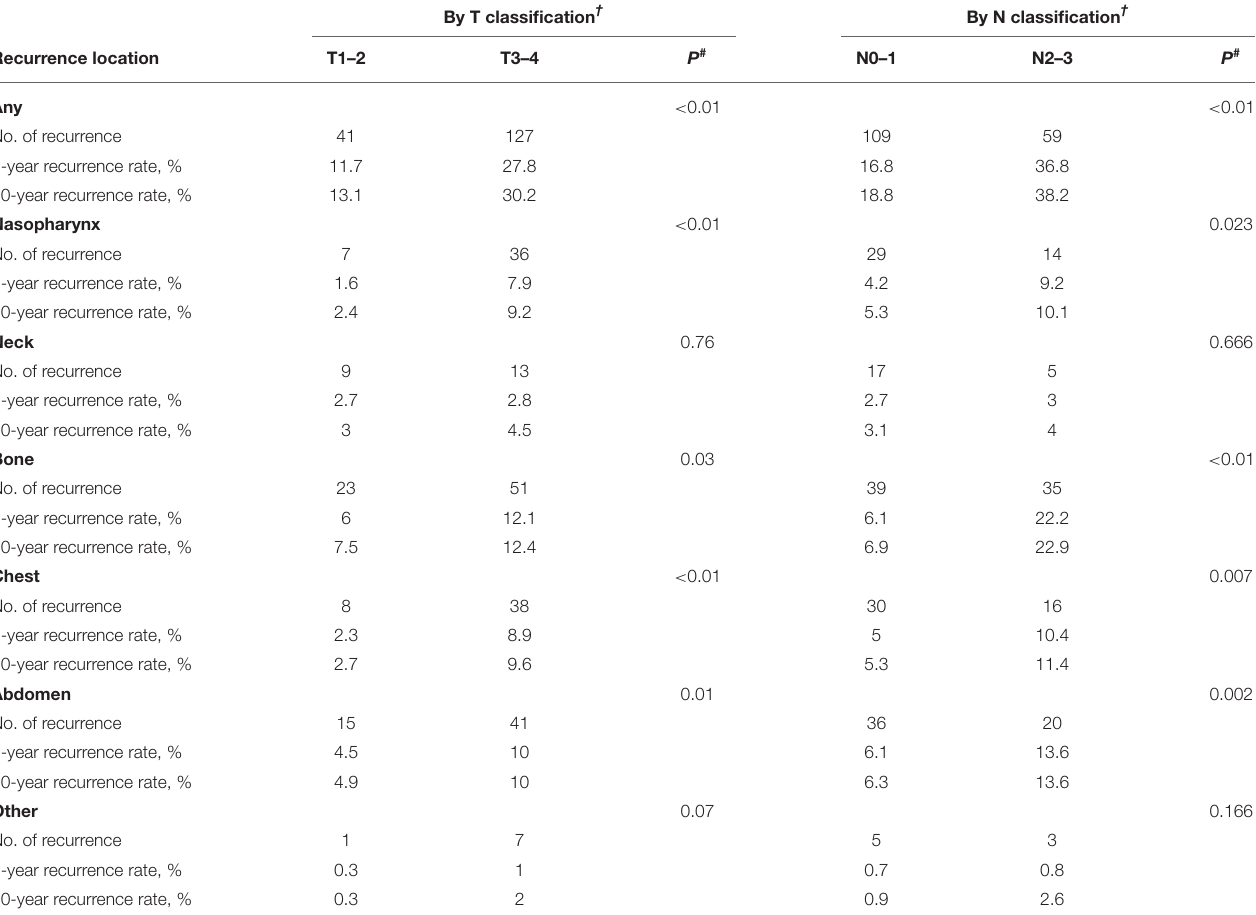
TABLE 4 | Recurrence rates at 5 and 10 years by location among different